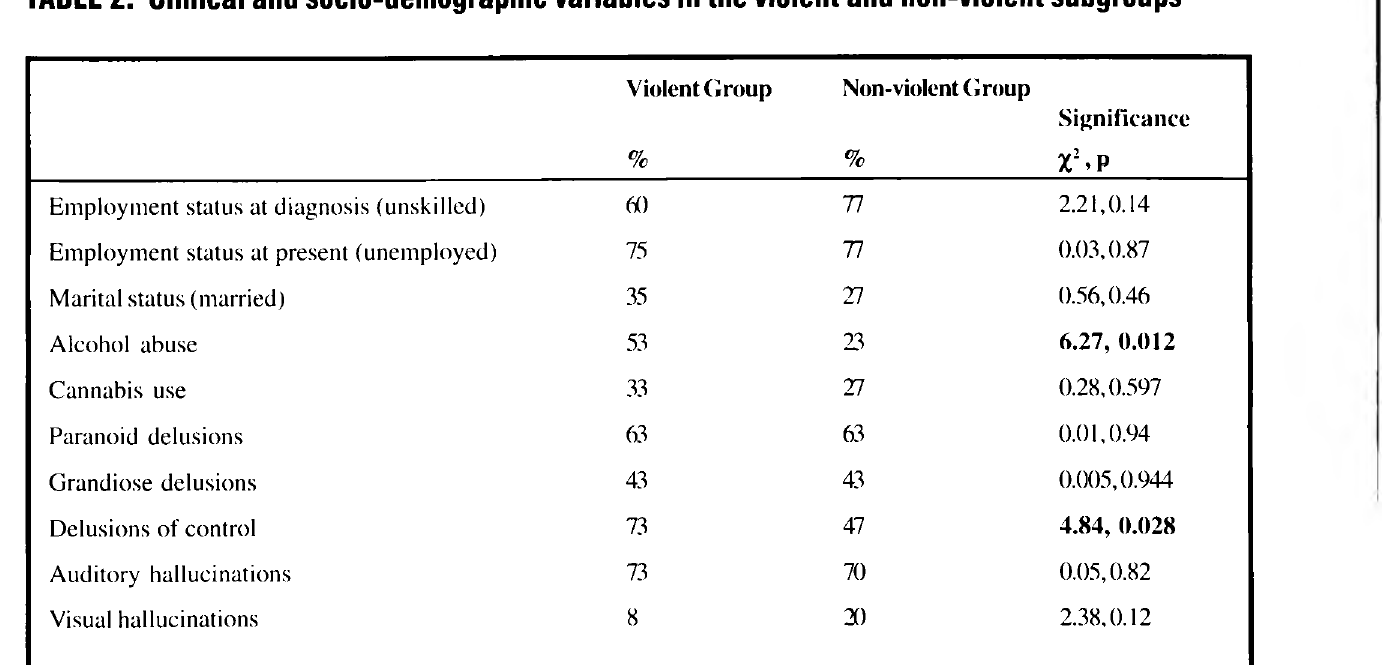
TAB LE 2: Clinical and socio-demographic variables in the violent and non-violent